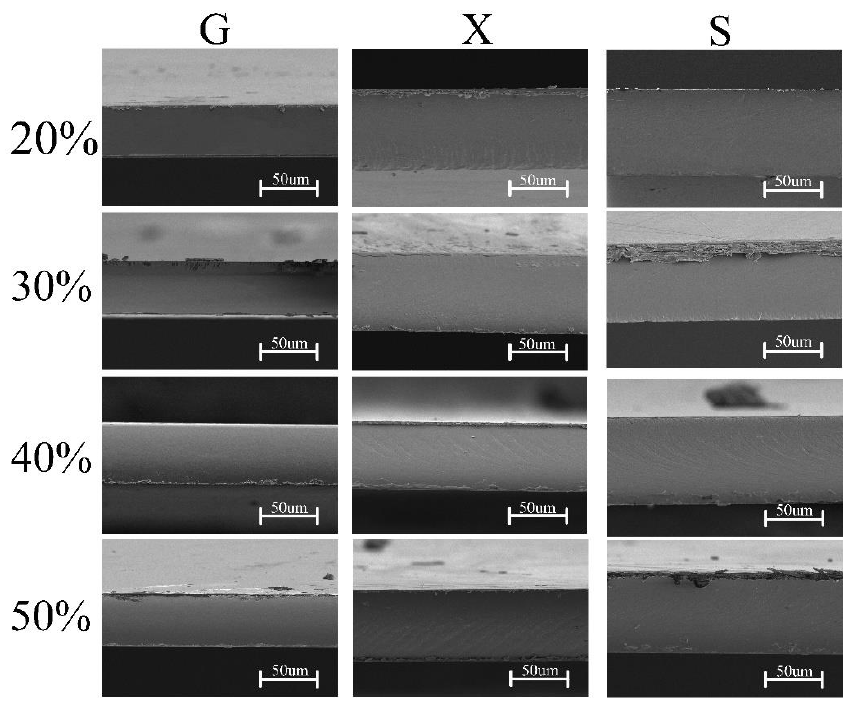
Figure 4. Cross-sectional surface morphologies of the funoran film with different additions of plas- ticizers.